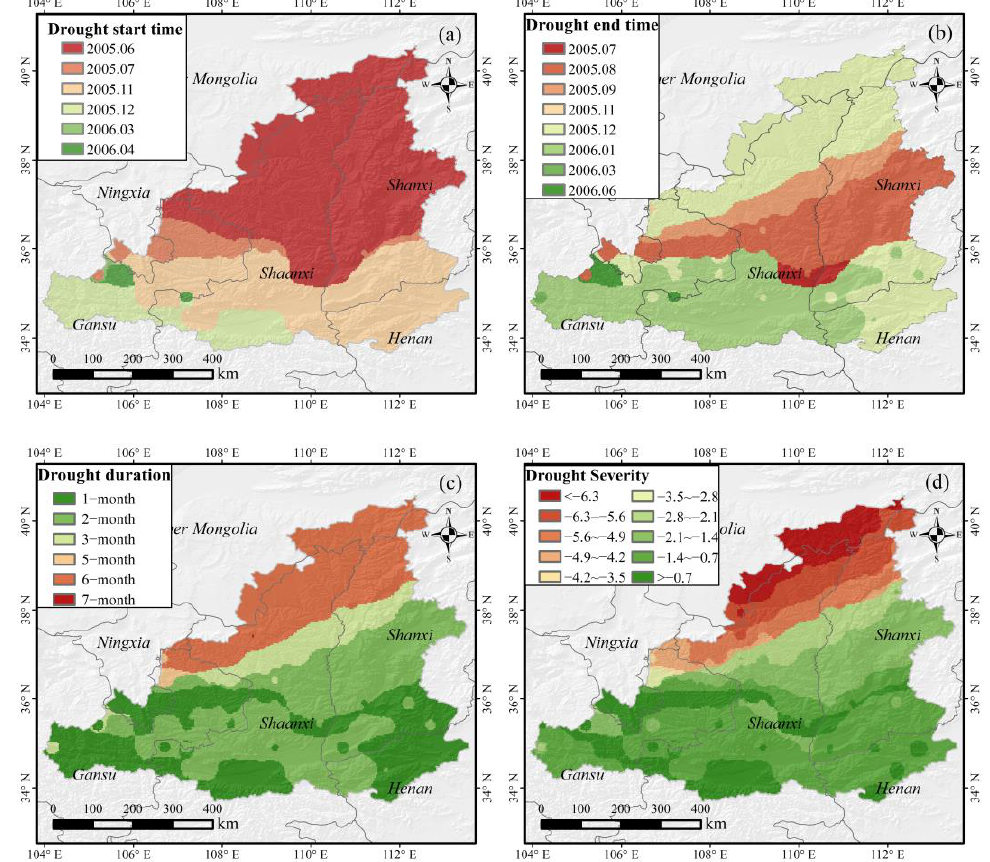
Figure 4. The spatial patterns of ( a ) the drought start time; ( b ) the drought end time; ( c ) the drought duration; ( d ) the drought severity. The start, end, duration and severity in ( a – d ) were identified based on the smoothed SPEI.